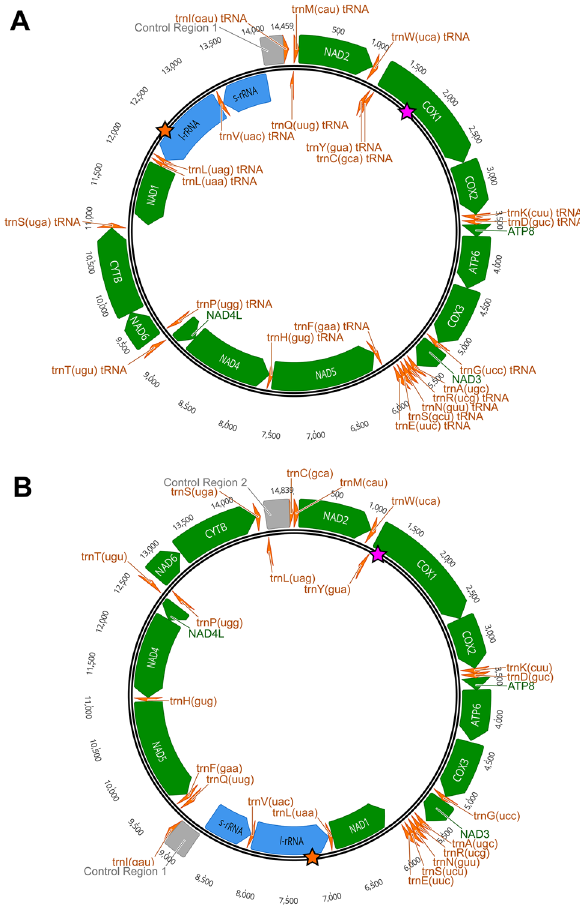
Figure 1. Mitogenome organizations of Group A and B ticks. Representative mitogenome organizations are depicted for what we termed Group A tick taxa, Argasidae, Nuttalliellidae, Prostriates ( A ), and Group B taxa, Metastriates ( B ). Protein coding genes are colored green and are labeled with their gene acronym. Transfer RNAs are colored orange while ribosomal RNAs are colored blue. The non-coding controls regions are indicated with grey boxes. Gene feature directions are indicated by location either above (positive-sense) or below (negative-sense) the mid-line. Primer set 1 was designed in the cox1 gene (pink star) and primer set 2 was designed in the 16S rRNA gene (orange star) of both